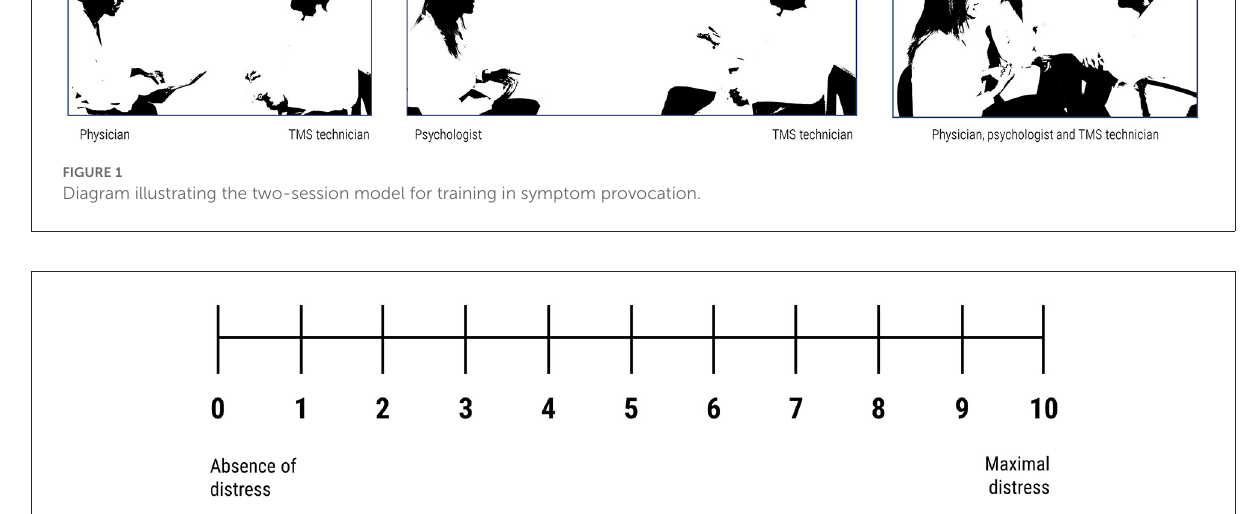
FIGURE2 Visual Analog